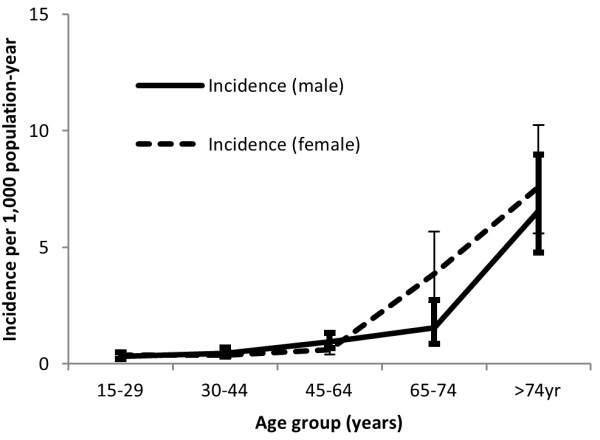
The incidence of hospitalised pneumonia per 1,000 persons by age group and gender. Incidence among male population were showed in solid line and those among female population were showed in dashed line. 95% confidence interval of each points were showed in vertical lines.